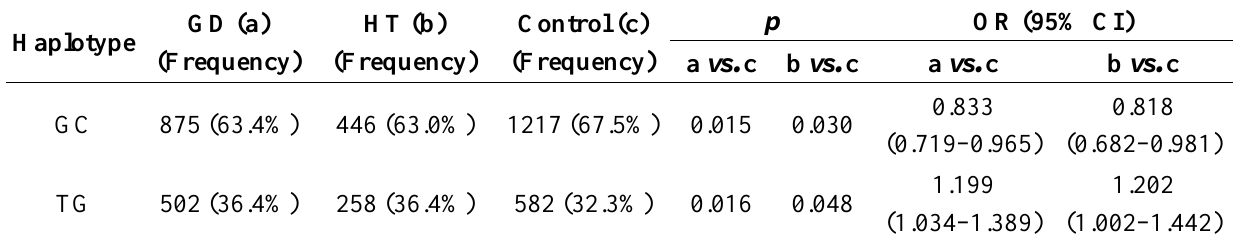
Table 6. Haplotypic association analysis of rs7574865, rs10181656,